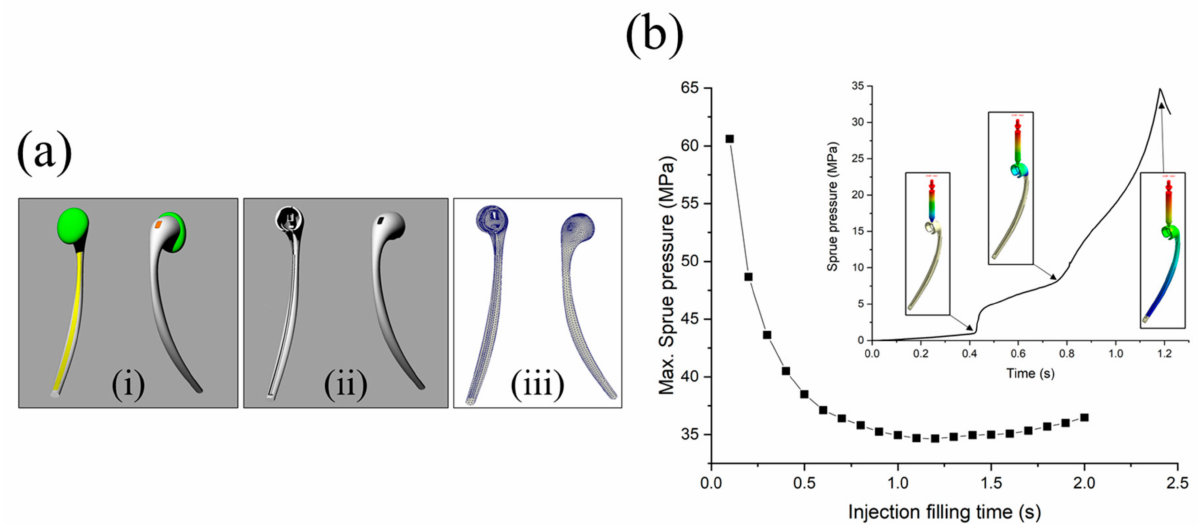
Figure 4. ( a-i ) Geometrical structure of the earphone-like product. ( a-ii ) Computer-aided design model and ( a-iii ) mesh generation for the injection part. ( b ) Maximum sprue pressure with respect to filling time. The inset shows the variation of the sprue pressure at a filling time of 1.2